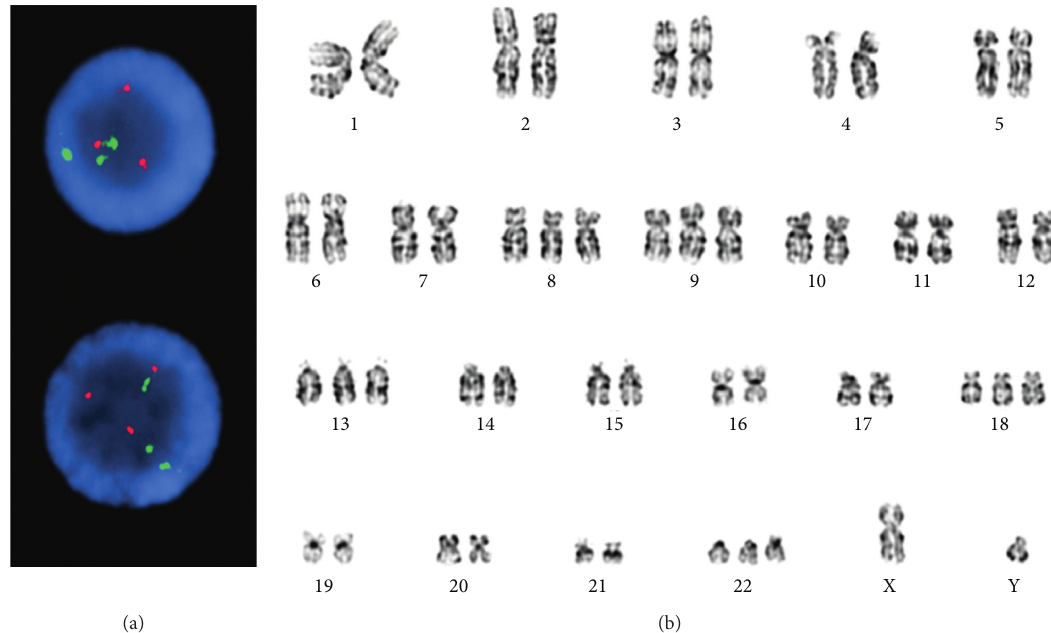
Figure 5: (a) Fluorescence in situ hybridization (FISH) studies on interphase cells showing BCR and ABL1 FISH probe signals, dual fusion probe (Cytocell) and (b) representative G -banded karyogram showing relapsed clone of the inv(16)(p13.1q22) primary